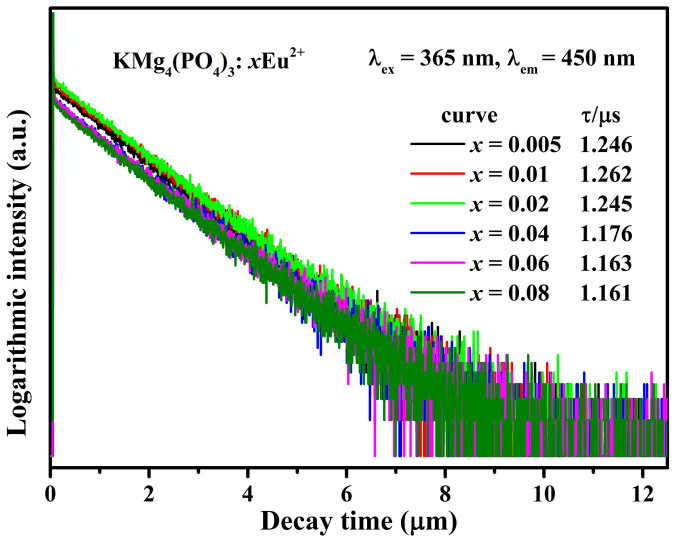
Decay lifetime tests of KMg4(PO4)3:xEu2+ (x = 0.05–0.08) detected at 450nm for Eu2+ emission.